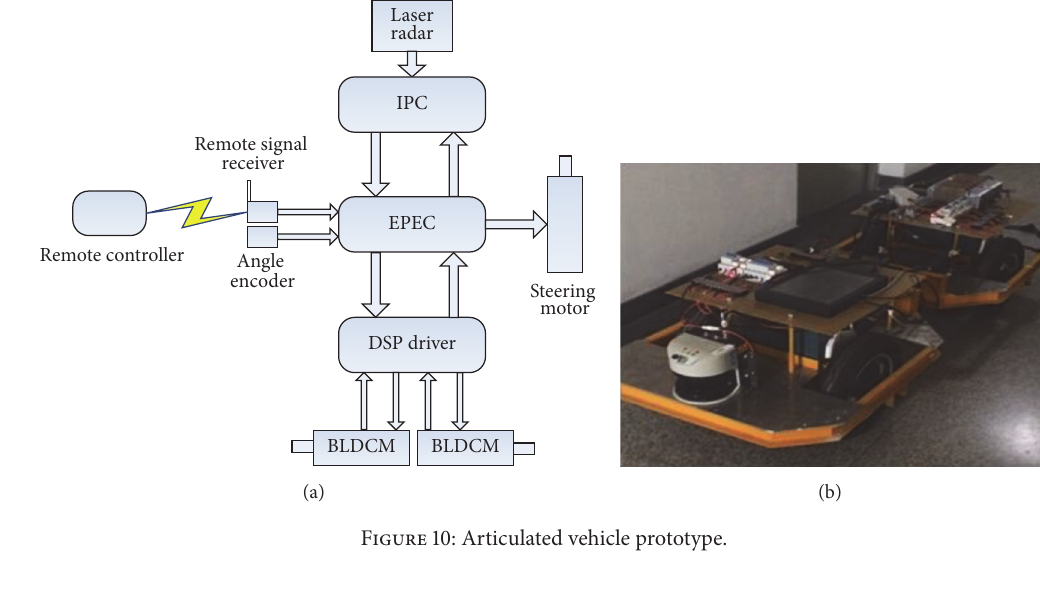
Figure 10: Articulated vehicle prototype.